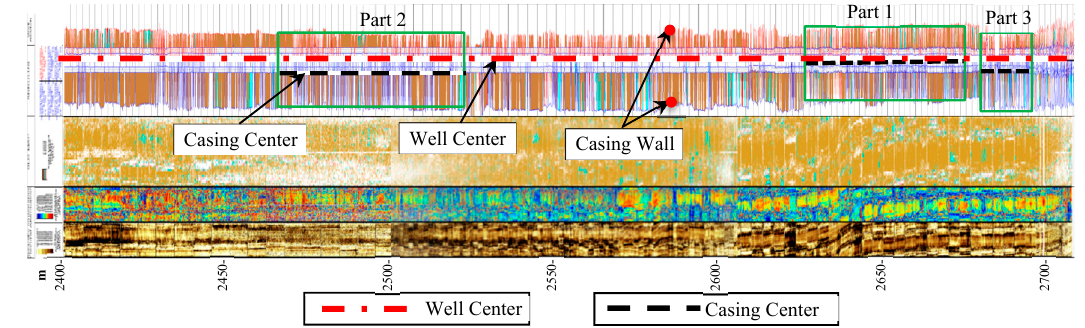
Figure 2. Isolation Scanner measurements show the quality of cementing work along a horizontal section of a well.